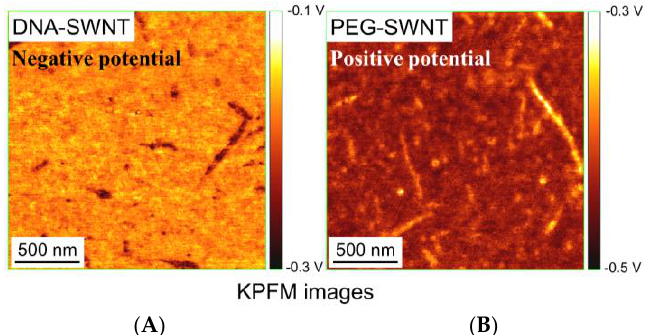
Figure 4. Kelvin force microscopy (KPFM) images of DNA-SWNT hybrids and SWNTs functionalized with PEG. ( A ) DNA-SWNT hybrids. Hybrids of thymine 30 (T30) were used as ssDNA; ( B ) polyethylene glycol (PEG)-SWNTs. Samples were deposited on conductive Au-Pd-coated mica surface. DNA-SWNT hybrids and PEG-SWNT revealed negative and positive surface potential against the Au-Pd surface, respectively (reprinted from reference [71] with permission).